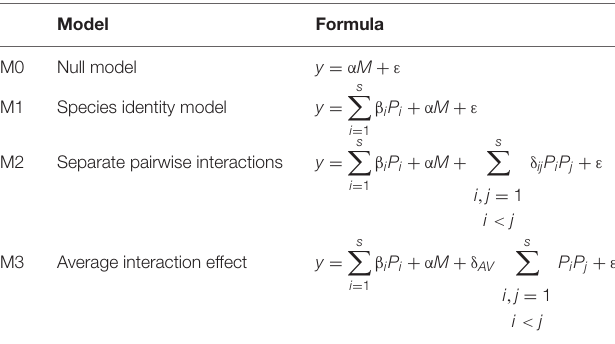
TABLE 1 | Hierarchical linear DI